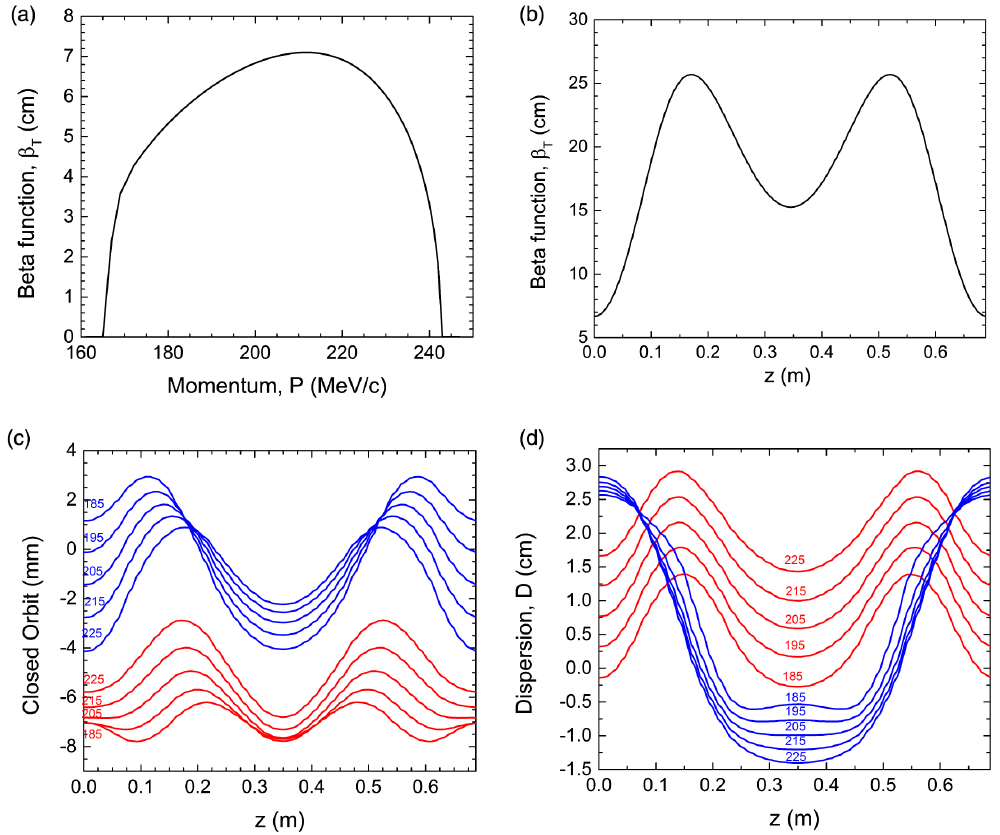
FIG. 5. Lattice properties for stage 11. (a) Beta function at the absorber center vs momentum; (b) beta function vs position at the reference momentum of 195 MeV =c ; (c) deviations from the central line of the channel in the horizontal direction (red) and in the vertical direction (blue). The different lines correspond to orbits of different momentum muons; (d) dispersion vs position for different momentum